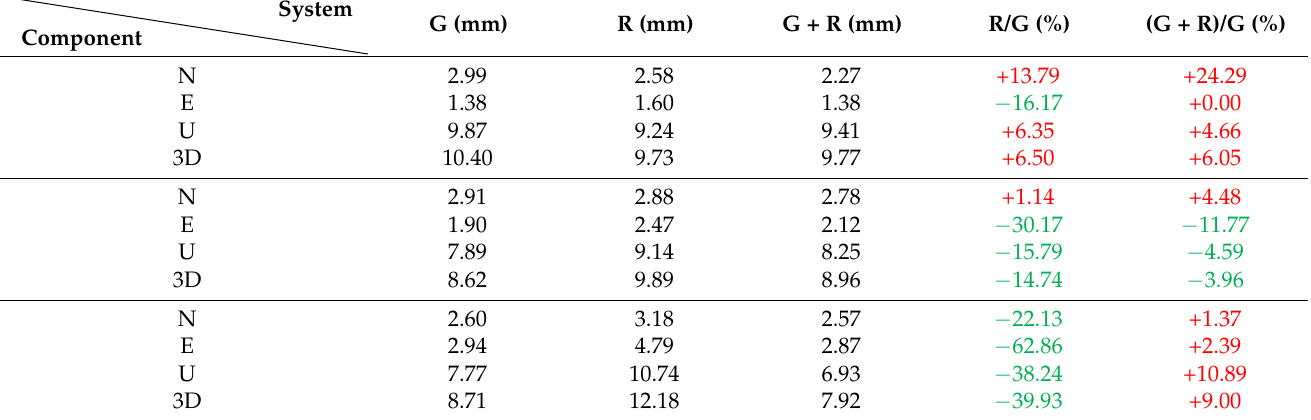
Table 6. The mean RMSE of coordinates of each network estimated with DD processing and their comparison among different processing modes (where R/G indicates the accuracy comparison of GLONASS and GPS results, (G + R)/G indicates the accuracy comparison of GPS+GLONASS results and GPS estimates. The positive red and negative green values indicate the percentage increment and reduction of accuracy,